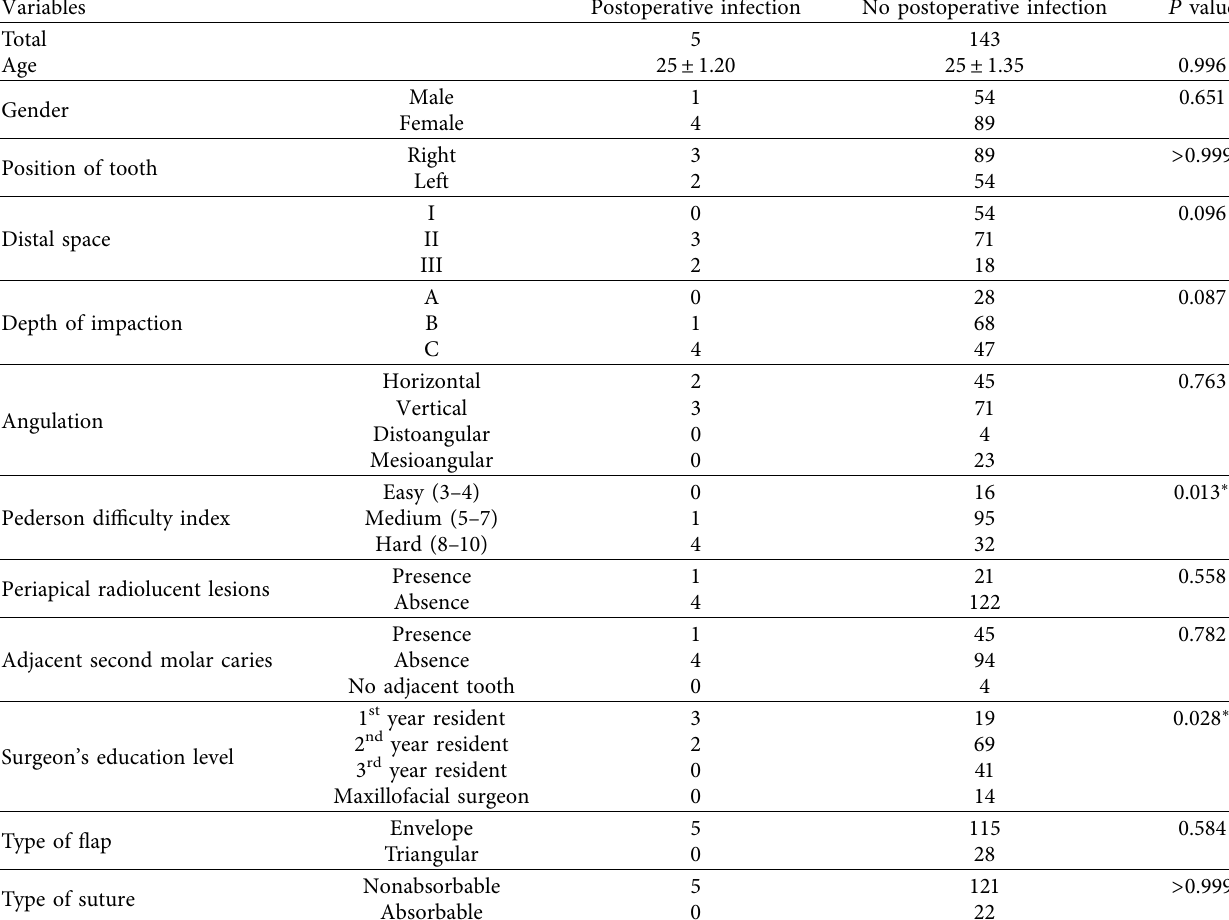
Table 1: Association between the predictor variables and the outcome variables.